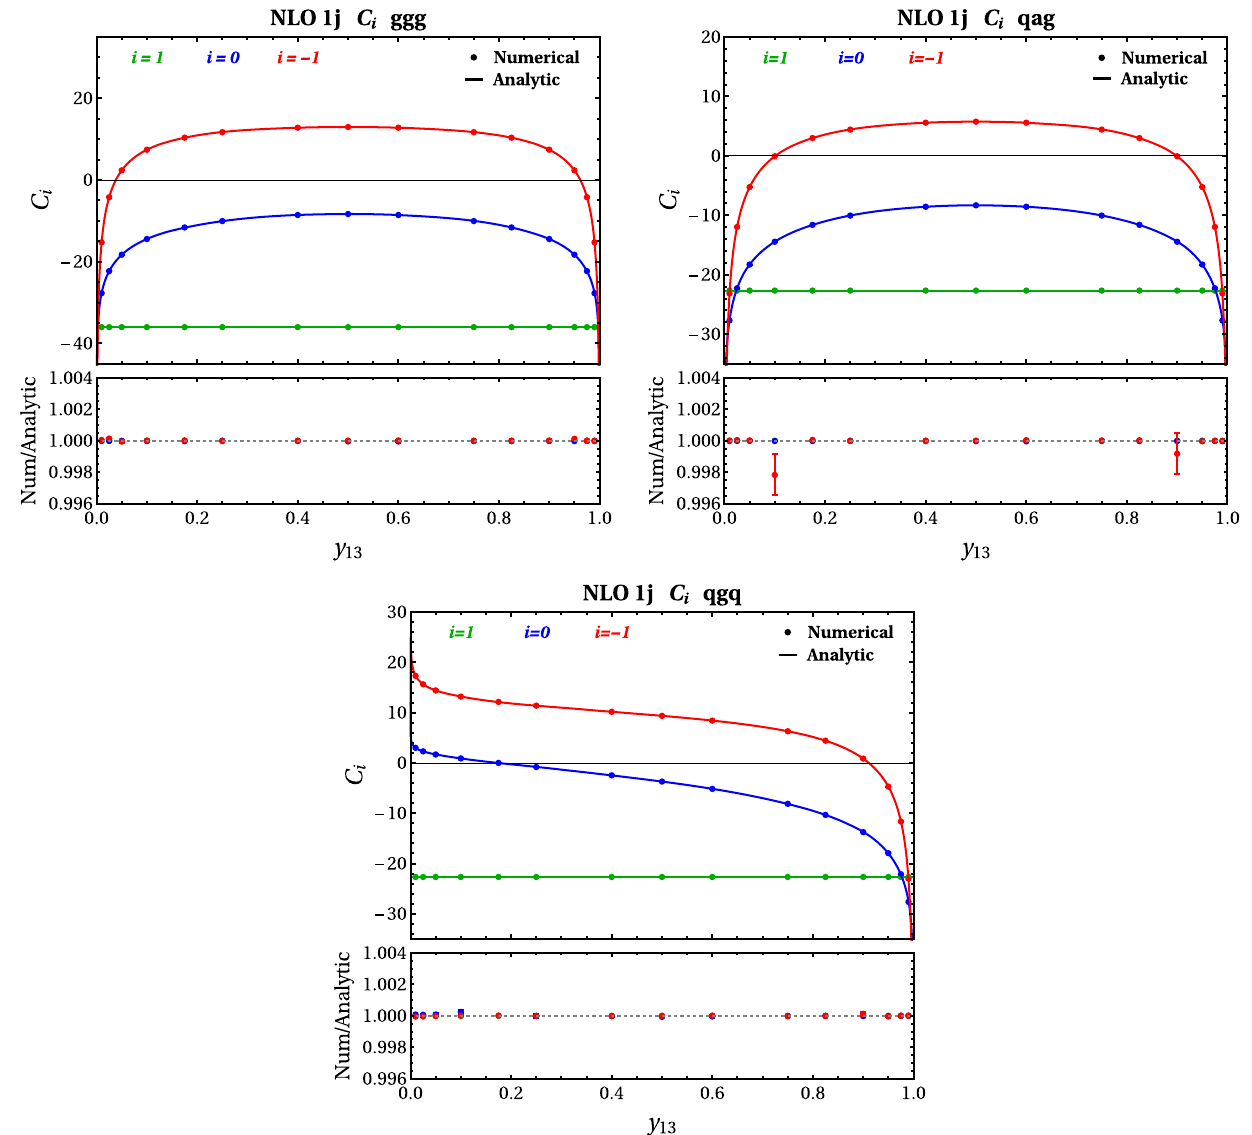
Fig. 1 Numerical results for the 1-jettiness soft function at NLO for the partonic channels gg → g , q ¯ q → g , and qg → q . We plot the coefficients of L 1 ( T 1 ) , L 0 ( T 1 ) , and δ( T 1 ) as functions of y 13 ∈ [ 0 , 1 ] . The known analytic results are taken from Ref.